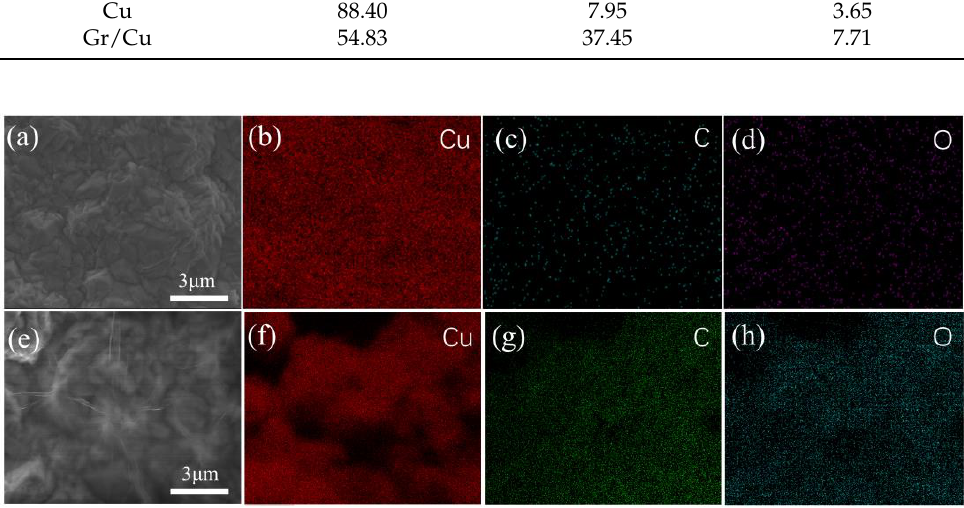
Figure 4. EDS elemental mapping analysis of the Cu and the Gr/Cu. SEM images of the ( a ) Cu and ( e ) Gr/Cu, and ( b , f ) the Cu element, ( c , g ) C element, and ( d , h ) O element.